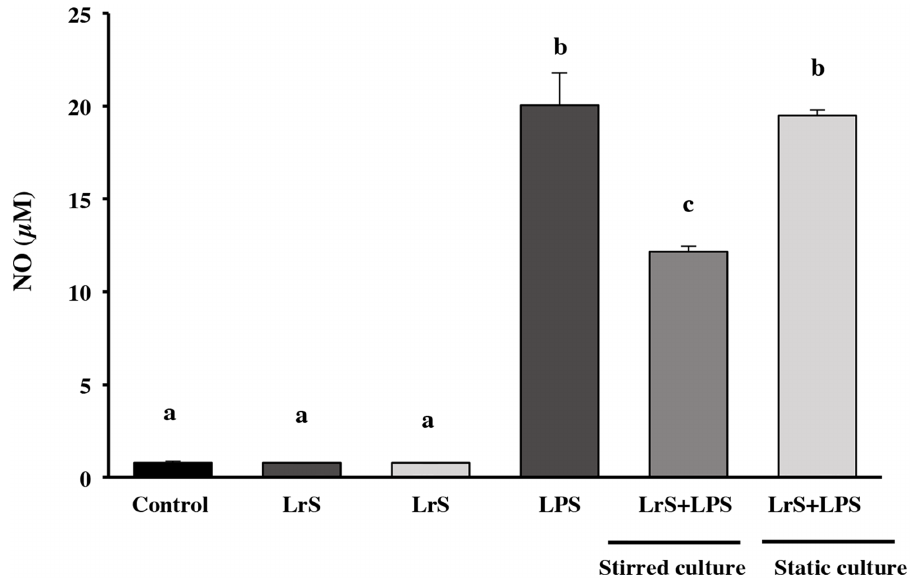
Fig 2. Effect of LrS on NO production by RAW 264.7 macrophages. LrS production by bacteria grown in under static and stirred conditions was evaluated in RPMI 1640 medium, and their anti-inflammatory effect was checked on LPS challenged RAW cells. NO was measured in culture supernatants by Griess assay. Data are representative result of three independent experiments. Values not sharing the same letter were significantly different ( p -value < 0.05).